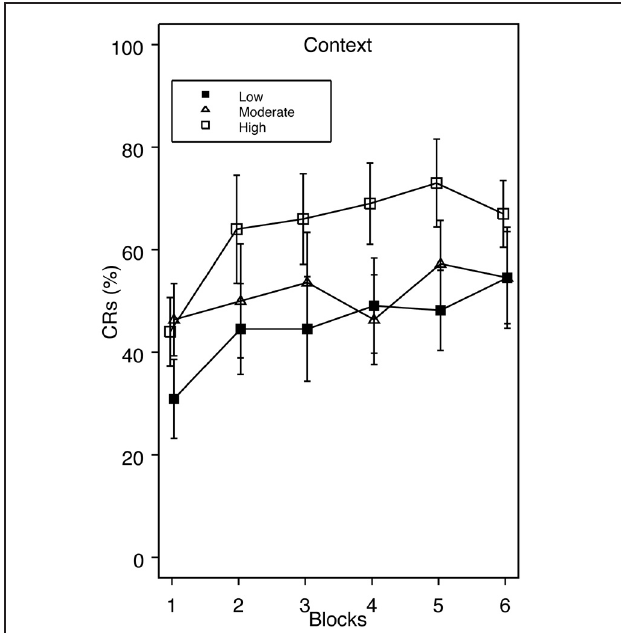
FIGURE 3 | Acquisition of eyeblink conditioning for group Context across a range of low, moderate, and high trait anxiety. Enhanced CR acquisition is apparent in group High relative to Moderate and Low. Specific comparisons revealed significant differences in CRs between groups High and Low on blocks 3 and 5, and between groups High and Moderate on block